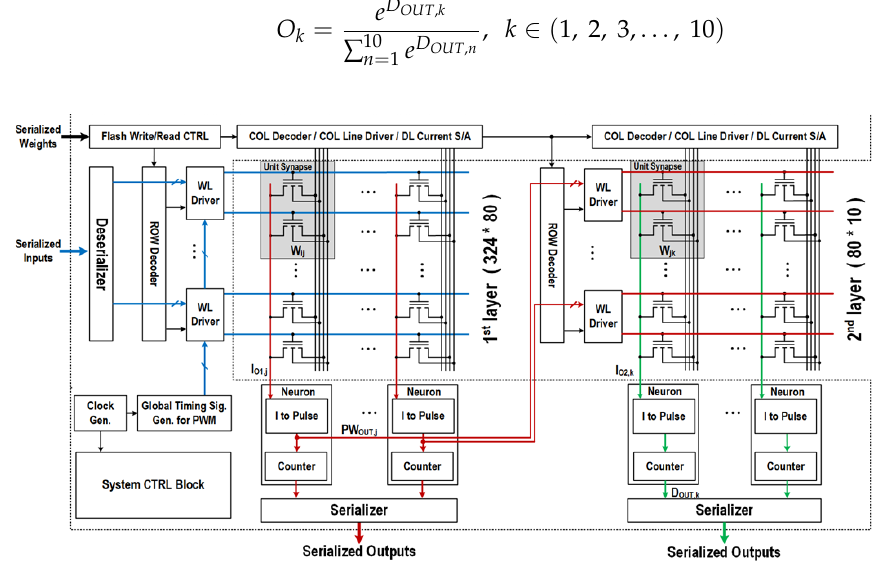
Figure 1. Block diagram of the proposed neural network accelerator with eFlash synapse array.